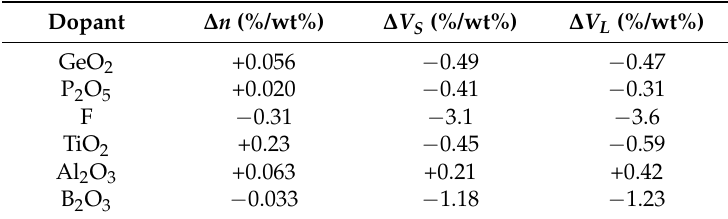
Table 2. Empirical effect of some common dopants on the optical index and shear and longitudinal acoustic velocities of silica. Data from [55]. Dopant ∆ n (%/wt%) ∆ V S (%/wt%) ∆ V L (%/wt%) GeO 2 +0.056 − 0.49 − 0.47 P 2 O 5 +0.020 − 0.41 − 0.31 F − 0.31 − 3.1 − 3.6 TiO 2 +0.23 − 0.45 − 0.59 Al 2 O 3 +0.063 +0.21 +0.42 B 2 O 3 −